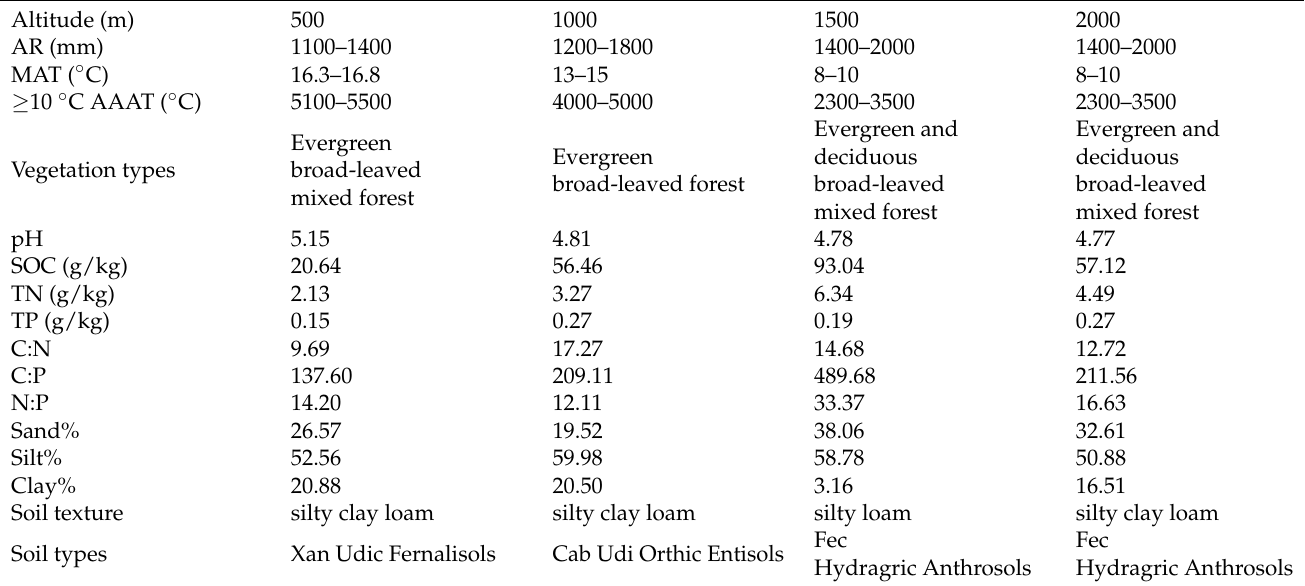
Table 1. Environmental factors of sample